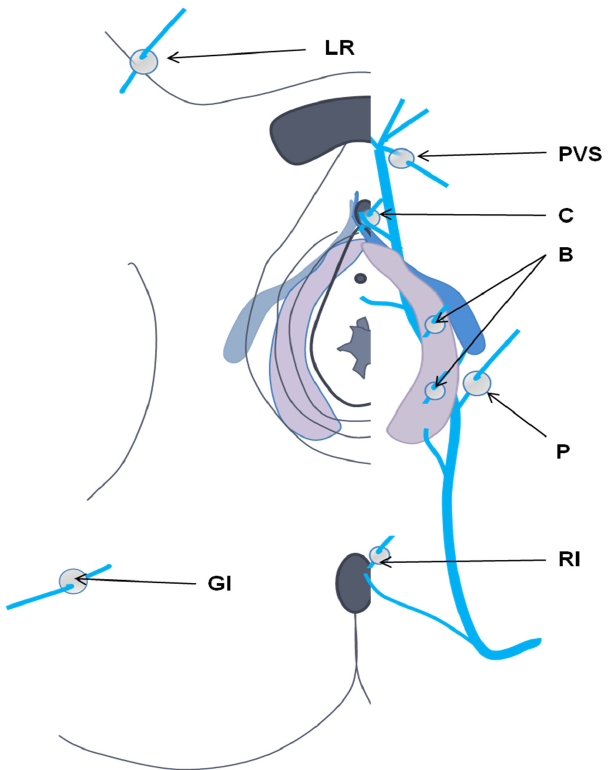
Figure 2. Cutaneous projection of pelvic leak points (perforation). LR, round ligament; PVS, venous plexus of Santorini; C, clitoral piercing; B, bulbar; P, perineal; GI, lower gluteal